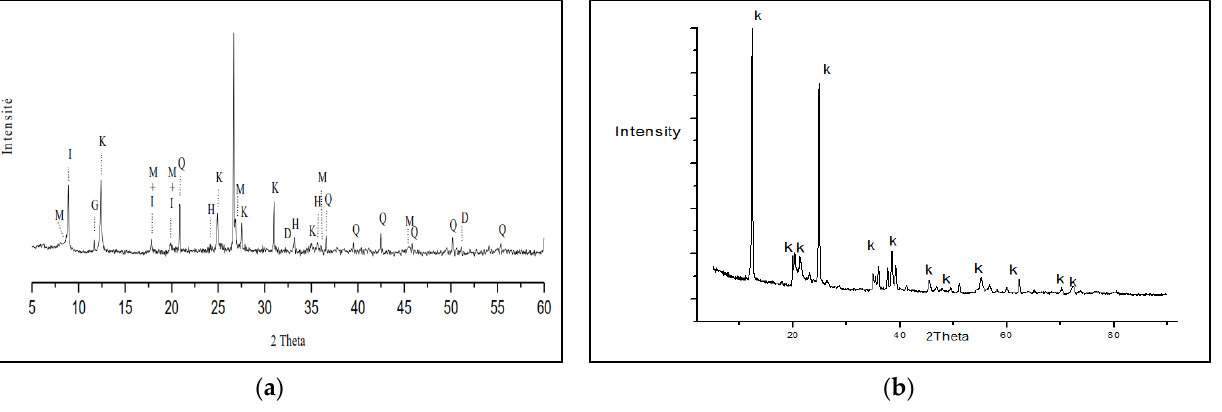
Figure 1. XRD diffractograms:( a ) natural Tunisian clay; ( b ) kaolin. With: K: kaolinite (00-001-0527); I: illite (00-009-0343); M: muscovite (00-001-1098); G: gypsum (04-0093817); H: hematite (04-008-8479);Q: quartz(00-06); and D: dolomite(00-001-0527).